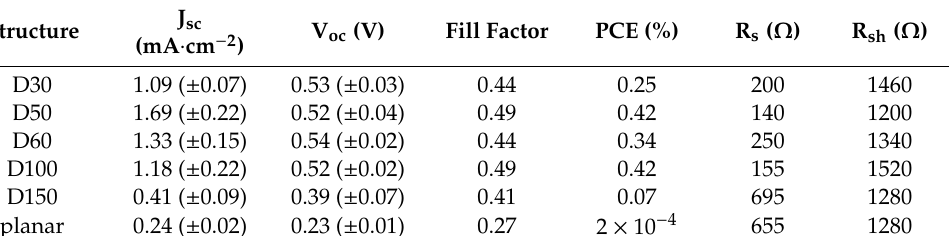
Table 1. Photovoltaic performance parameters of Si / GaN NW / P3HT:PC 71 BM heterostructures for nanowire diameters 30, 50, 60, 100, 150 nm.